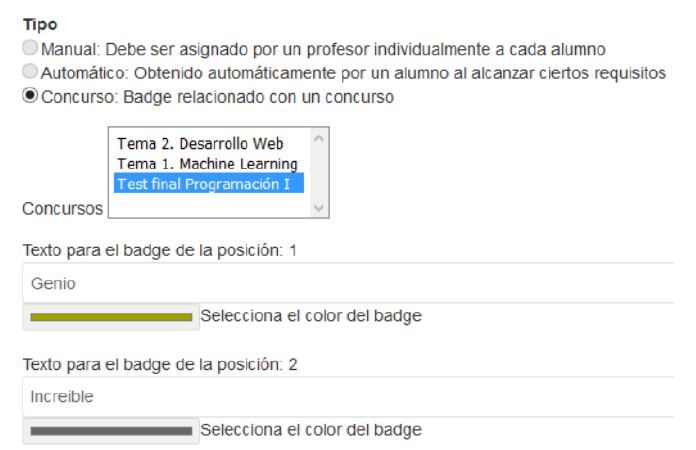
Figure 3. Configuration of badge by